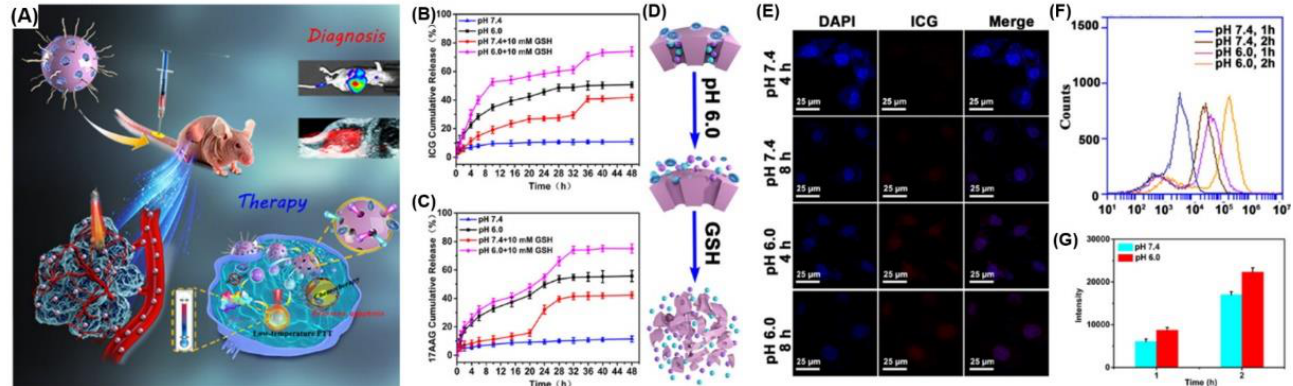
Figure 13. ( A ) Graphical abstract of chemo-drug-gated biodegradable hollow mesoporous organosilica nanotheranostics. In vitro ICG ( B ) and 17AAG ( C ) release profiles from ICG – 17AAG@HMONs – Gem – PEG at different pH values with or without addition of 10 mM GSH. ( D ) pH-induced hydrolysis of acetal bonds and biodegradation of the HMON (hollow mesoporous organic silica nanocapsules) framework, triggering the pH/GSH-responsive payload release from the nanoplatform. ( E ) Confocal fluorescence images of MDA-MB-231 cells treated with ICG–17AAG@HMONs–Gem–PEG at pH 6.0 or 7.4 for 2 or 4 h. Scale bar: 25 µ m. ( F ) Flow cytometry histogram profiles of intracellular fluorescence